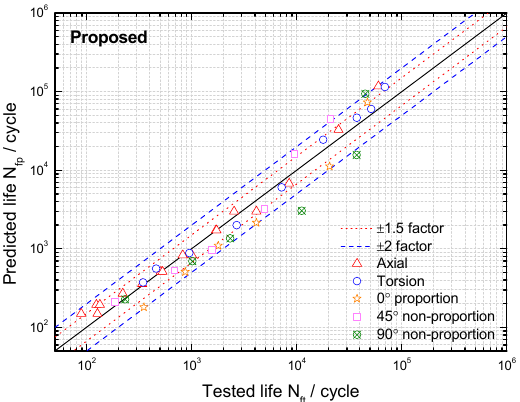
(10)) and ( b ) the MGSE model (Equation (11)) for GH4169 at 650 ° C.